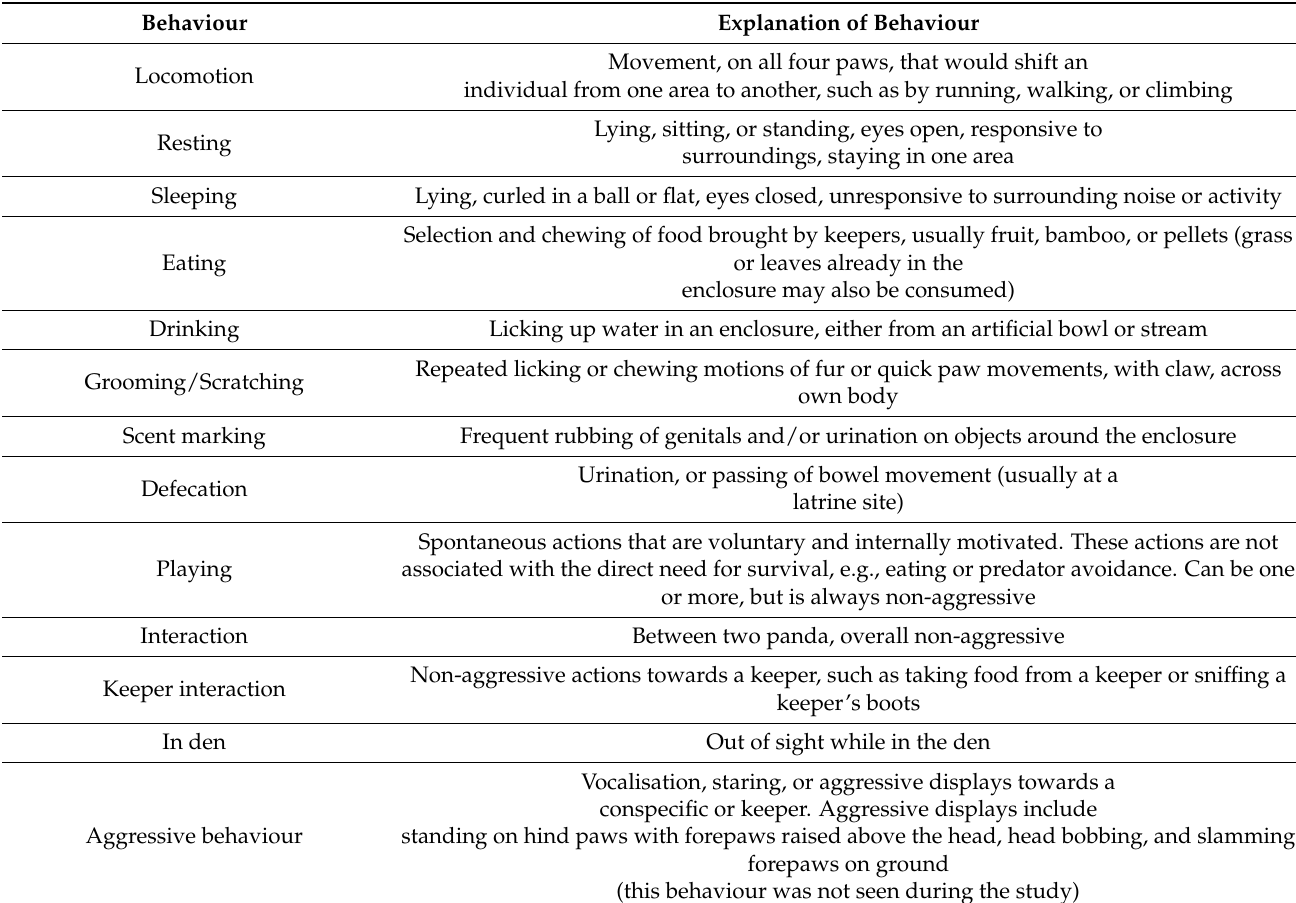
Table 2. Ethogram of red panda